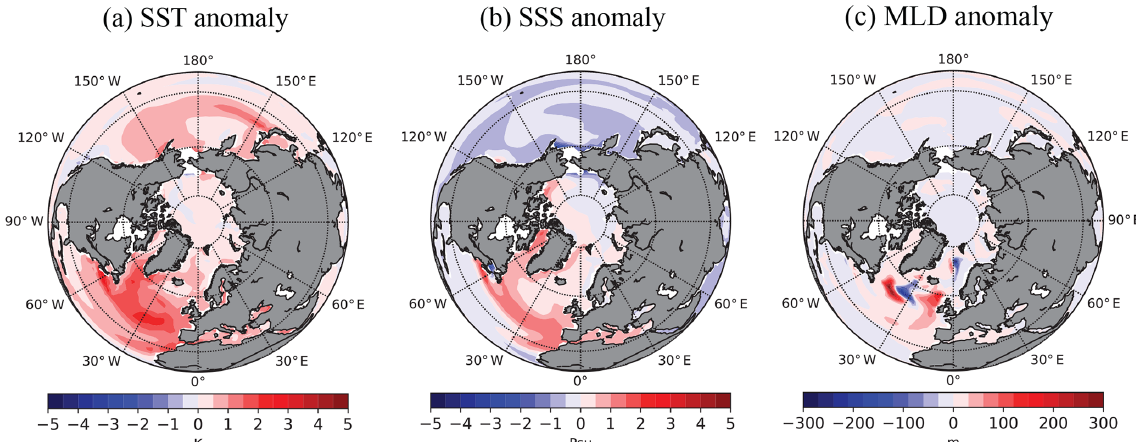
Figure 4. The differences in the mean annual sea surface temperature (a) , sea surface salinity (b) , and the mixed layer depth (c) between Eoi400 and PlioMIP 1.